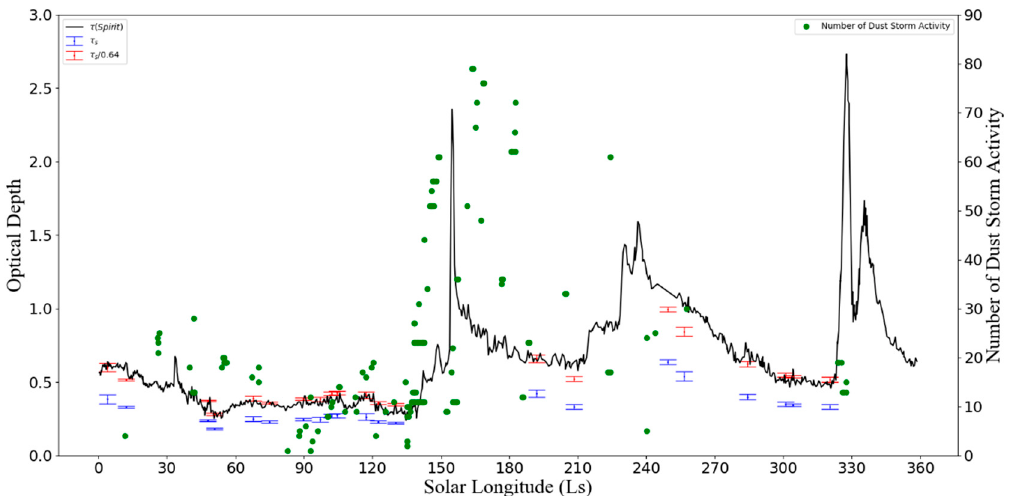
Figure 3. The distribution of optical depth at different solar longitudes in MY29 (the blue error bars represents the optical depth of the inspection area of the Spirit rover calculated by the shadow method, the red error bars represents the optical depth divided by the correction coefficient, the black line represents the optical depth measured by the data of the Spirit rover [16], and green dots represents the number of dust storm activity recorded in the Mars Dust Activity Database (MDAD) at 0°–30°S in MY29 [28]).